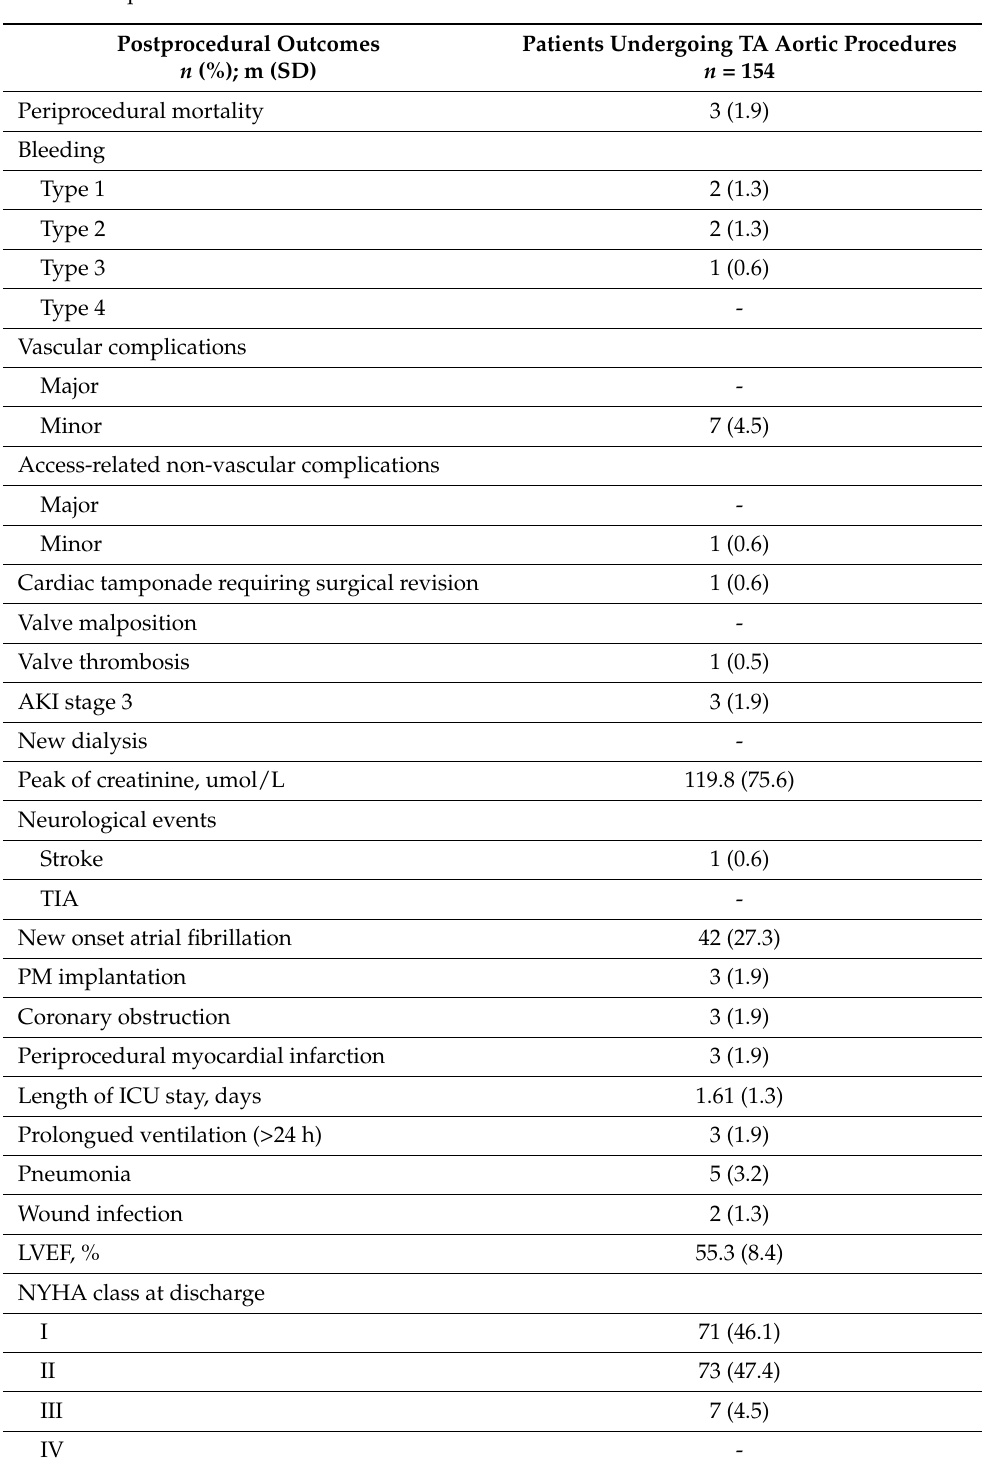
Table 3. Periprocedural